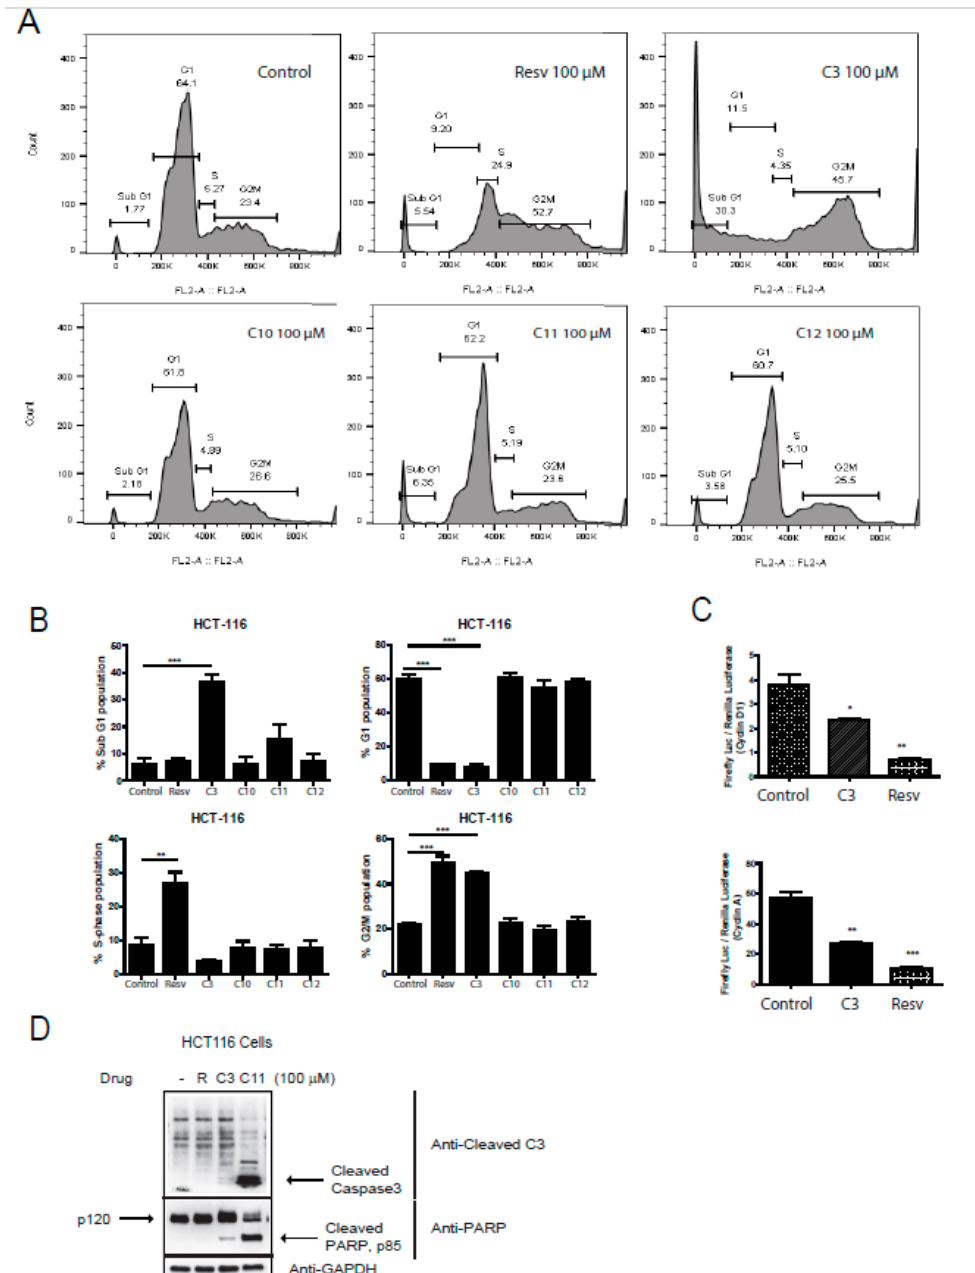
Figure 4. E ff ect of resveratrol and derivatives on cell cycle progression in human colon cancer and normal cell lines. ( A ) Cell cycle analysis in HCT-116 cells using propidium iodide (PI) staining followed by fluorescent activated cell sorting (FACS) analysis. In HCT-116 colon cancer cell line, resveratrol (100 µ M) appears to induce S-phase and G2 / M arrest whereas C3 (100 µ M) significantly induces cell death and a G2 / M arrest. N = 3–6. ( B ) Lower panels are quantitation of above cell cycle profiles. ( C ) Induction of cyclin expression was determined in HCT-116 cells by a dual-luciferase assay with firefly luciferase (Luc) under the control of a promoter to drive expression of cyclin D1 and cyclin A, and renilla-ruciferase used as an internal control. Cells were treated with drugs for 24 h. Normalization was done against non-treated cells (100% activity). The induction of cyclins was determined by the ratio of firefly Luciferase / Renilla-Luc. Experiments were done in triplicates. * p -value < 0.05, ** p -value < 0.01, and *** p -value < 0.001. If not stated, p -value > 0.05. ( D ) HCT116 cells were treated with the indicated drugs at 100 µ M and immunoblotted for cleaved caspase 3 and PARP, markers for cell death. GAPDH was utilized as a loading